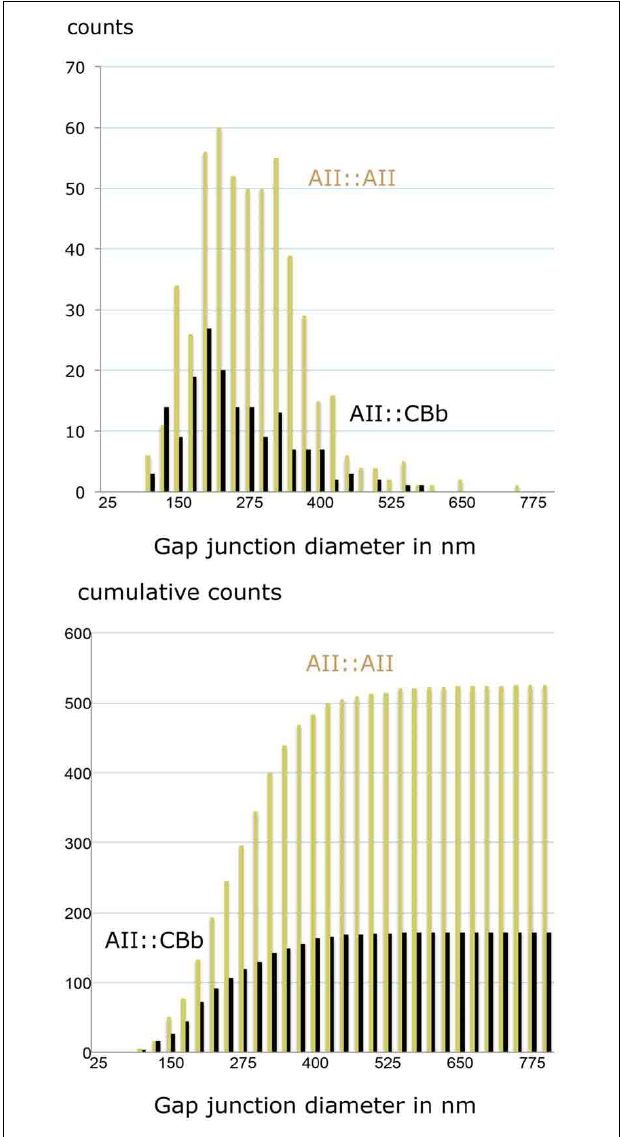
FIGURE 13 | Gap junction partnerships with AII cells. Top , size distribution. Bottom , cumulative size distribution. Both histograms are binned in 25nm increments. The cumulative frequency histograms are significantly different (Komolgorov–Smirnov, p = 0 . 0002).